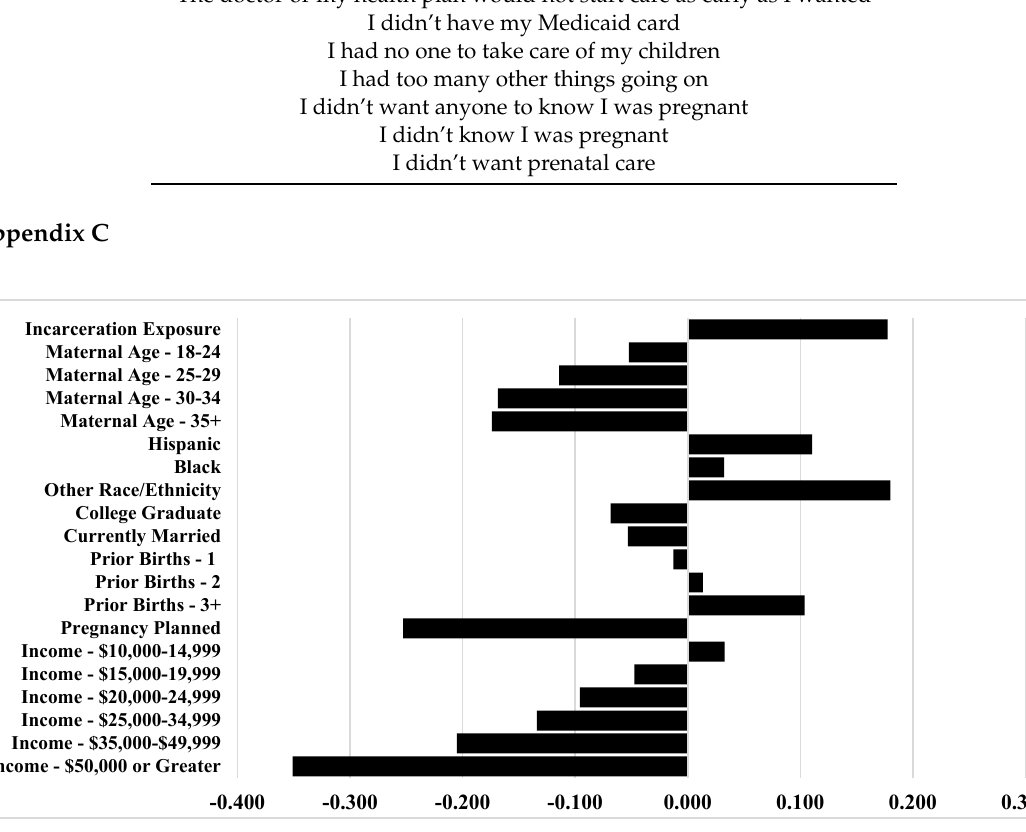
Figure C. Marginal Effects from Negative Binomial Regression of Incarceration Exposure on the Figure A1. Marginal E ff ects from Negative Binomial Regression of Incarceration Exposure on the Number of Prenatal Care Barriers ( N = 194,600). Number of Prenatal Care Barriers ( N =